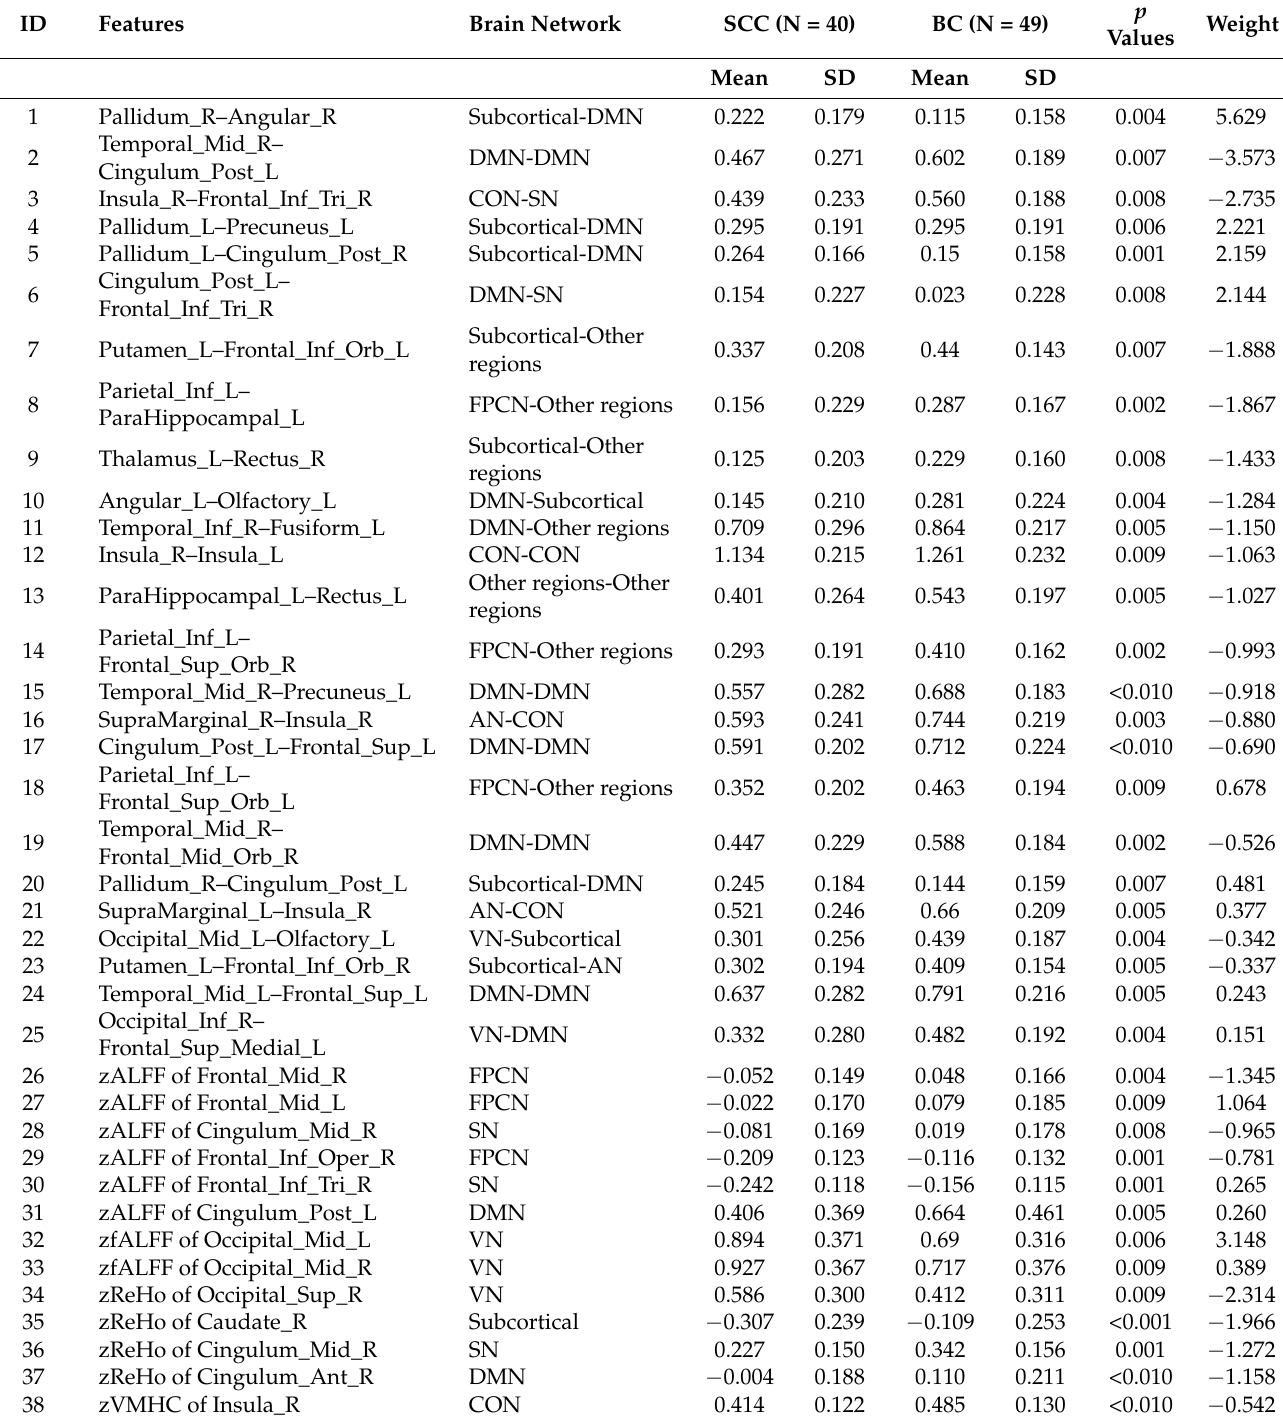
Table 2. The selected rs-fMRI features set for discriminating the SCC from BC